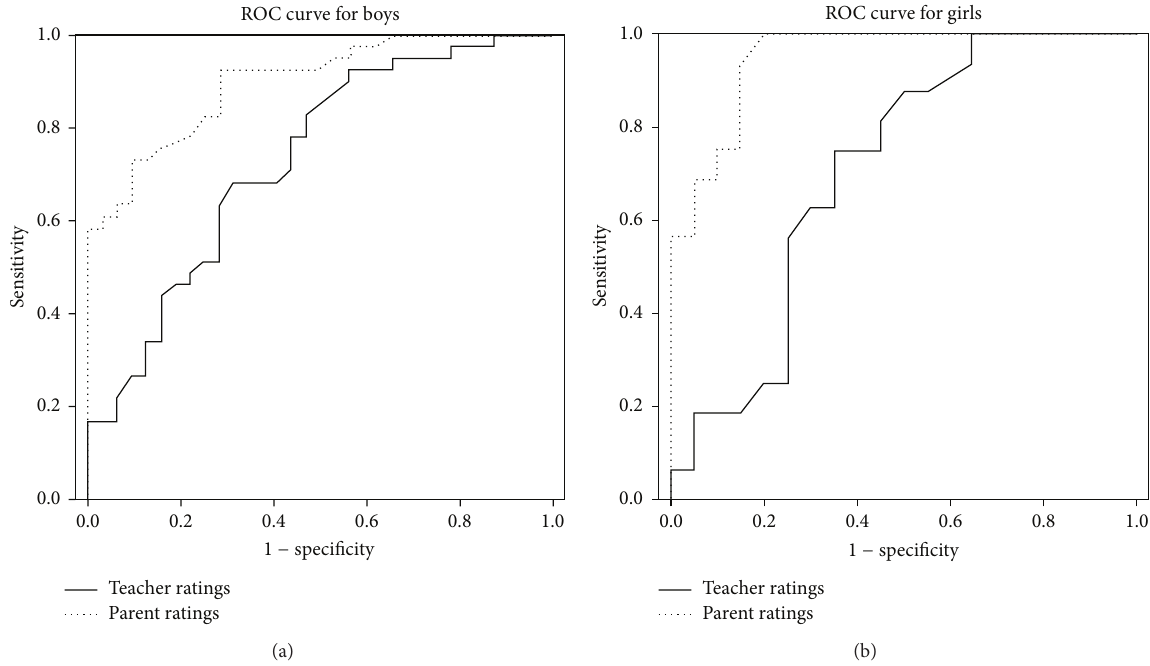
Figure 1: (a) Receiver operating characteristics (ROC) curve demonstrating sensitivity and specificity of both teacher and parent ratings for boys ( 𝑛 = 73 ). (b) Receiver operating characteristics (ROC) curve demonstrating sensitivity and specificity of both teacher and parent ratings for girls ( 𝑛 = 36